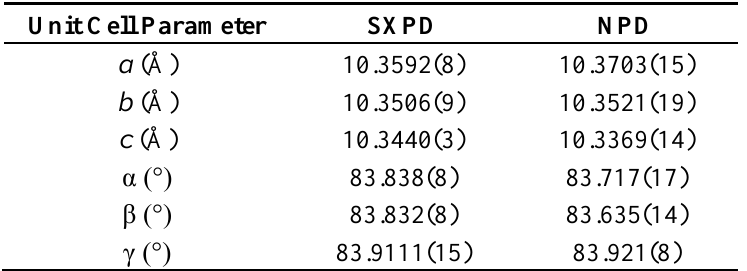
Table 6. Comparison of room temperature lattice parameters of Rb 2 TiCu 3 F 12 from SXPD and NPD